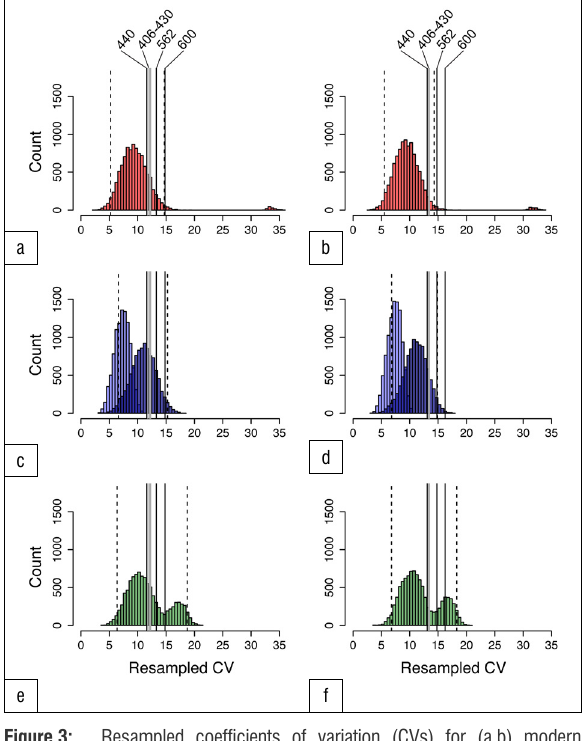
Figure 3: Resampled coefficients of variation (CVs) for (a,b) modern humans (red), (c,d) lowland gorillas (dark blue), mountain gorillas (light blue) and (e,f), chimpanzees (green) for sample sizes n =9 (left, excluding Sts 25) and n =10 (right, including Sts 25). Solid vertical lines indicate CVs for the Australopithecus africanus sample with different adult estimates for Taung – from left to right in each panel: 440 cm 3 , 22 estimates from this study (404–430 cm 3 ), 562 cm 3 , 34 and 600 cm 3 . 25 Dashed lines indicate 95% confidence intervals for each